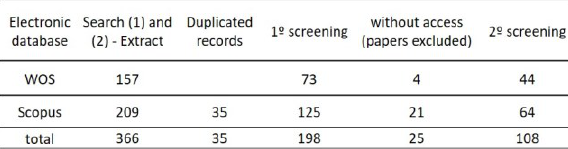
Table 3: Papers included and excluded during the Systematic